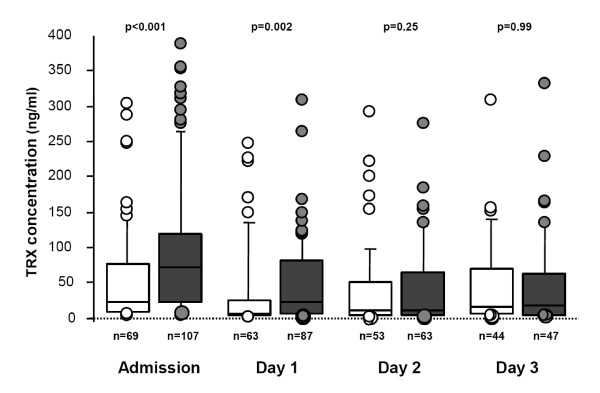
Serum thioredoxin (TRX) levels on admission, then 1, 2 and 3 days after cardiac arrest, according to the ICU survival. White boxes represent ICU survivors, grey boxes represent non-survivor patients. The median is shown by the horizontal line within the box. The values between the lower and upper quartiles (25th to 75th centiles) are within the box.